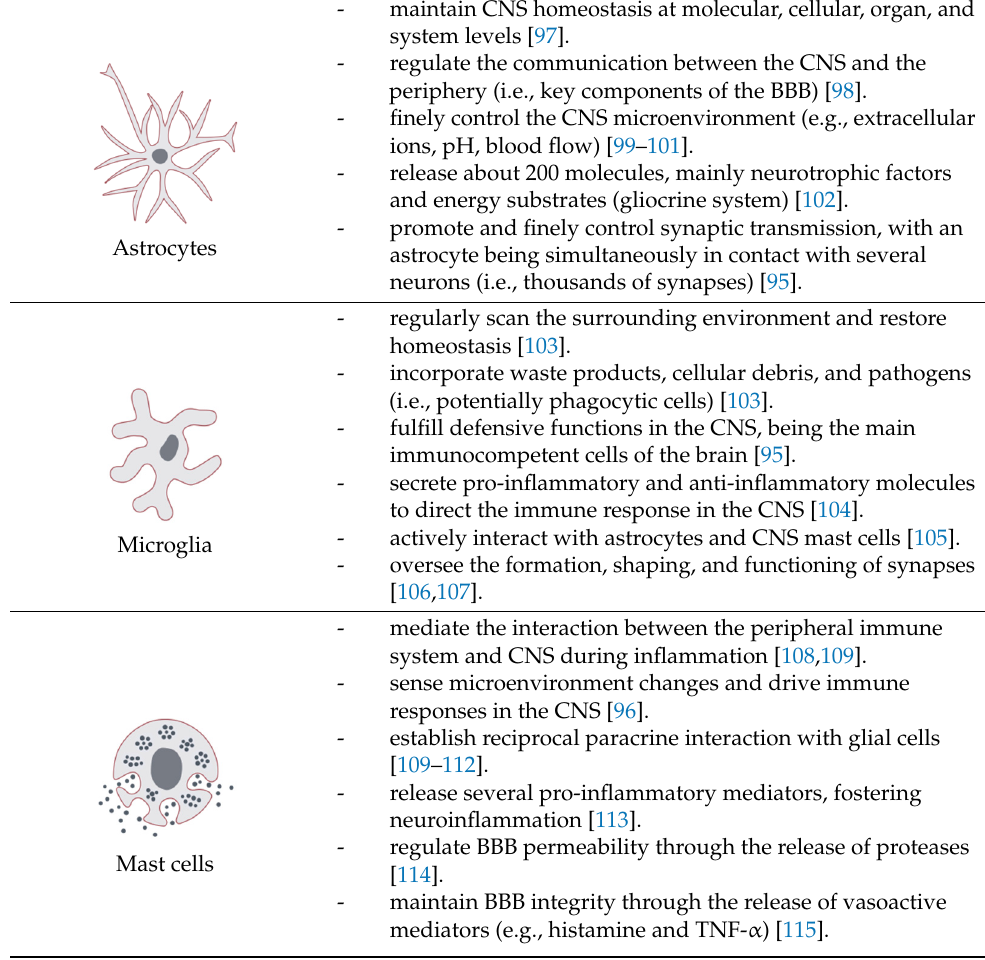
Table 2. Main functions of CNS glia and mast cells.